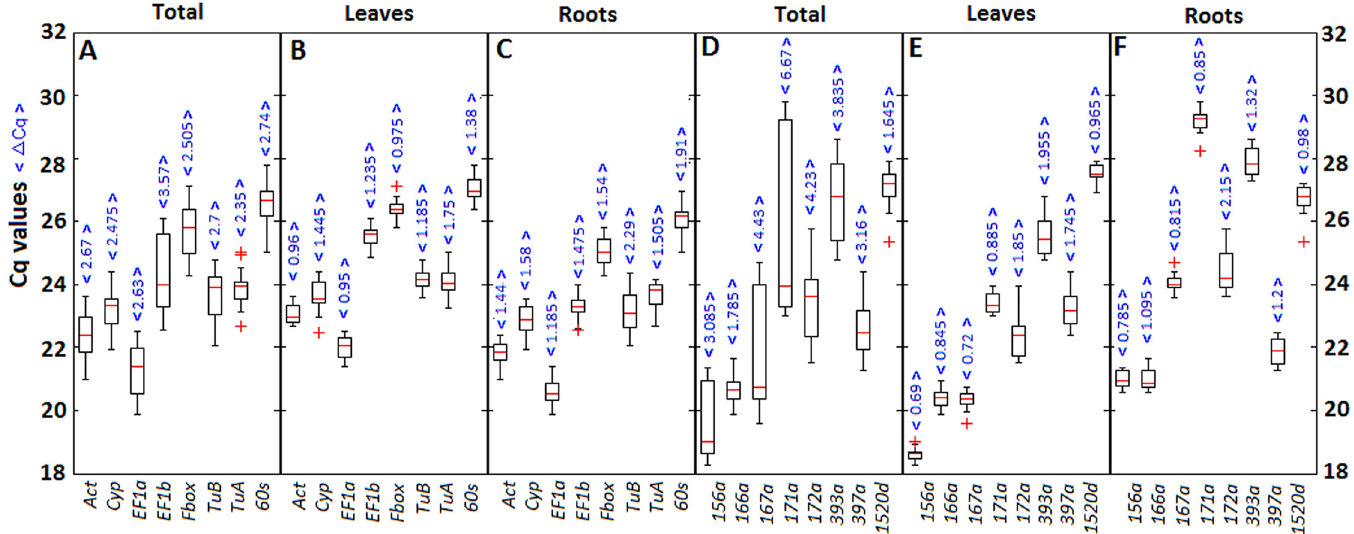
Fig 1. Boxplots of the quantification cycle (Cq) values of candidate reference mRNAs and candidate reference miRNAs. Boxplots of Cq values for each candidate reference mRNA/miRNAs were assessed in sets of samples, respectively(S1 Table). (A) Candidate reference mRNA genes were analyzed in leaf and root combined samples (n = 52). (B) Candidate reference mRNA genes were analyzed in leaf samples (n = 26). (C) Candidate reference mRNA genes were analyzed in root samples (n = 26). (D) Candidate reference miRNAs were analyzed in leaf and root combined samples (n = 52). (E) Candidate reference miRNAs were analyzed in leaf samples (n = 26). (F) Candidate reference miRNAs were analyzed in root samples (n = 26). The box indicates the 25th and 75th percentiles. The line across the box corresponds to the median, and whiskers represent the maximum and minimum values. The plus sign indicates the maximum or minimum